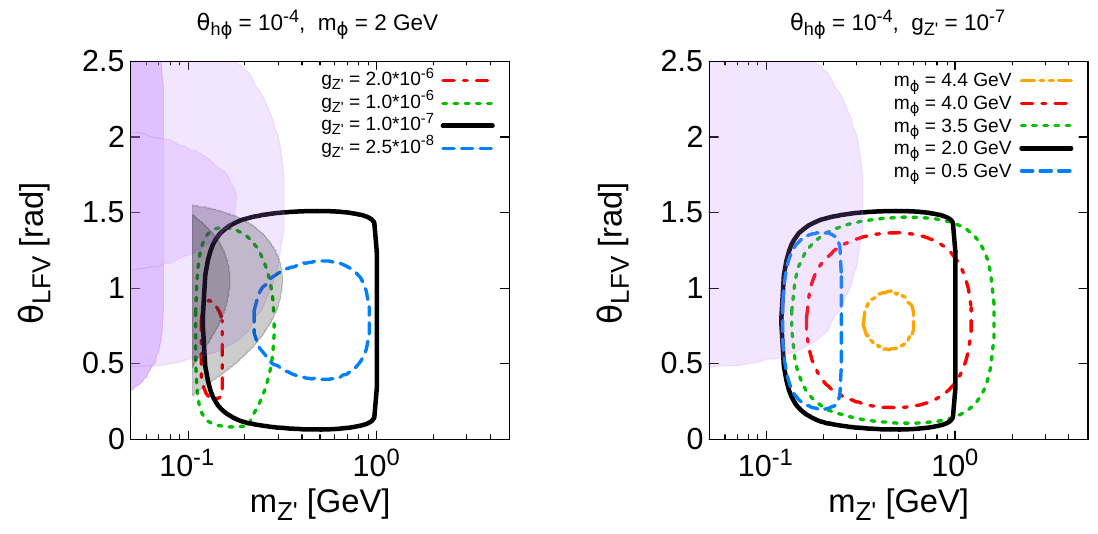
Figure 4 . The contour plots of 95 % C.L. sensitivity regions for the vector interaction in the m Z 0 − θ LFV plane. The purple shaded areas are excluded by E137 for g Z 0 = 10 − 7 (light), 2 . 5 × 10 − 8 (medium), and 10 − 6 (dark). The gray shaded areas are excluded by µ → eee for g Z 0 = 2 × 10 − 6 (light) and 10 − 6